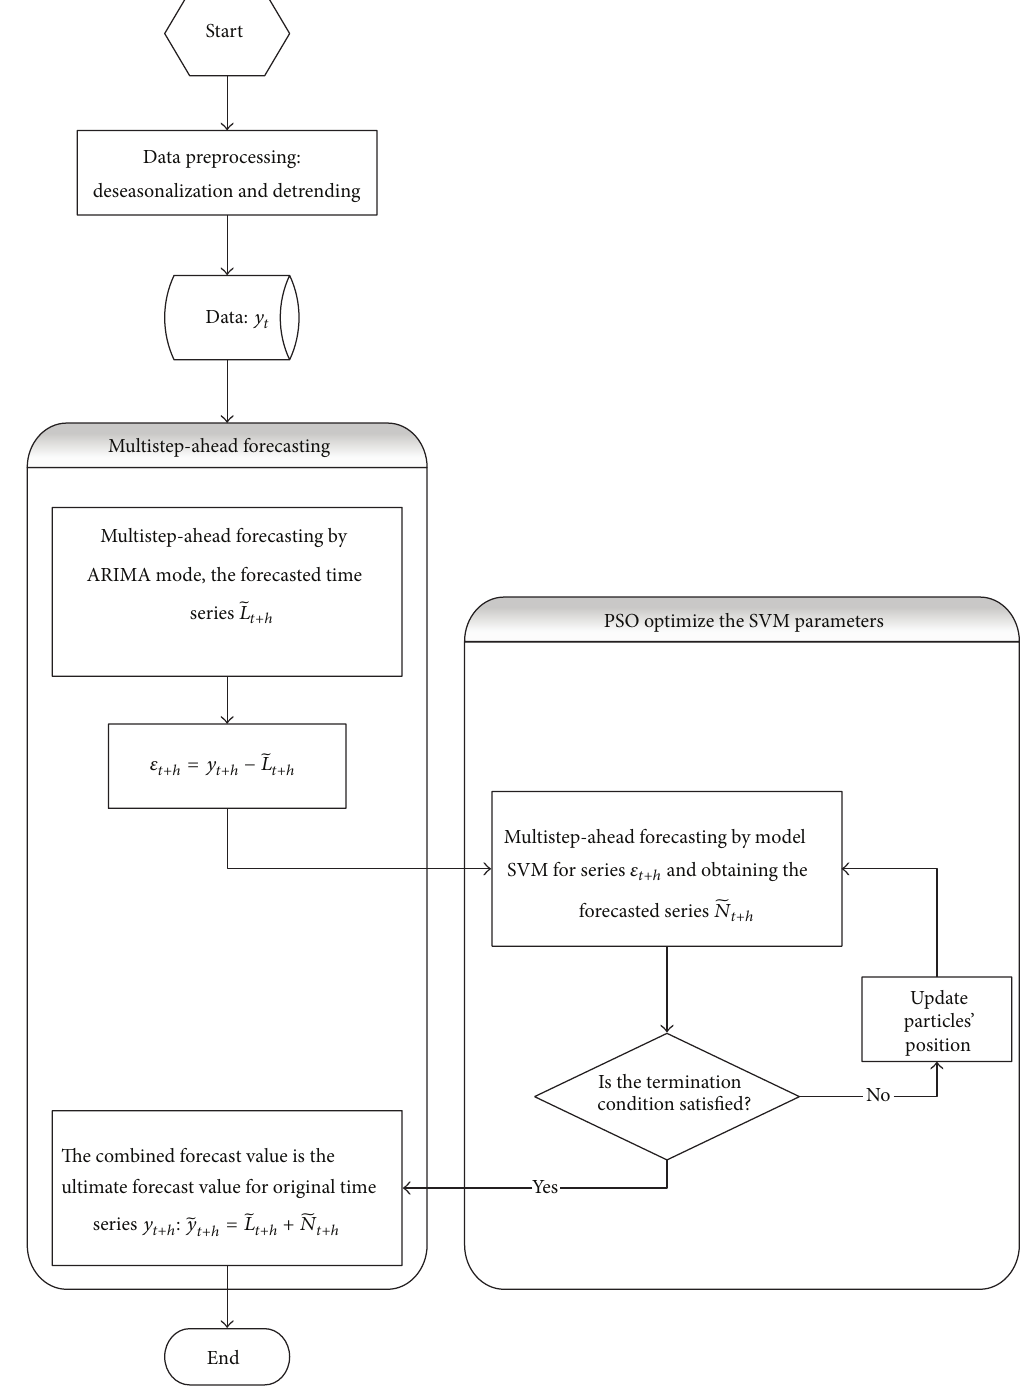
Figure 1: The flowchart of proposed multistep-ahead PSO-ARIMA-SVMs modeling framework.